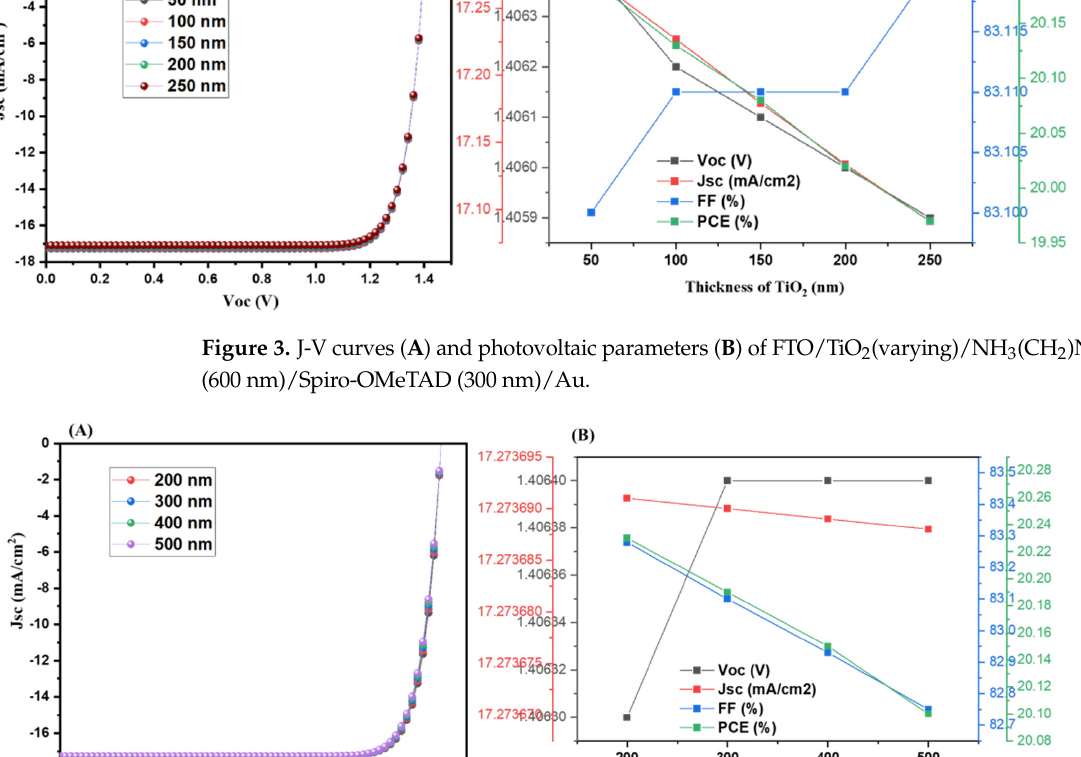
Figure 3. J ‐ V curves ( A ) and photovoltaic parameters ( B ) of FTO/TiO 2 (vary ‐